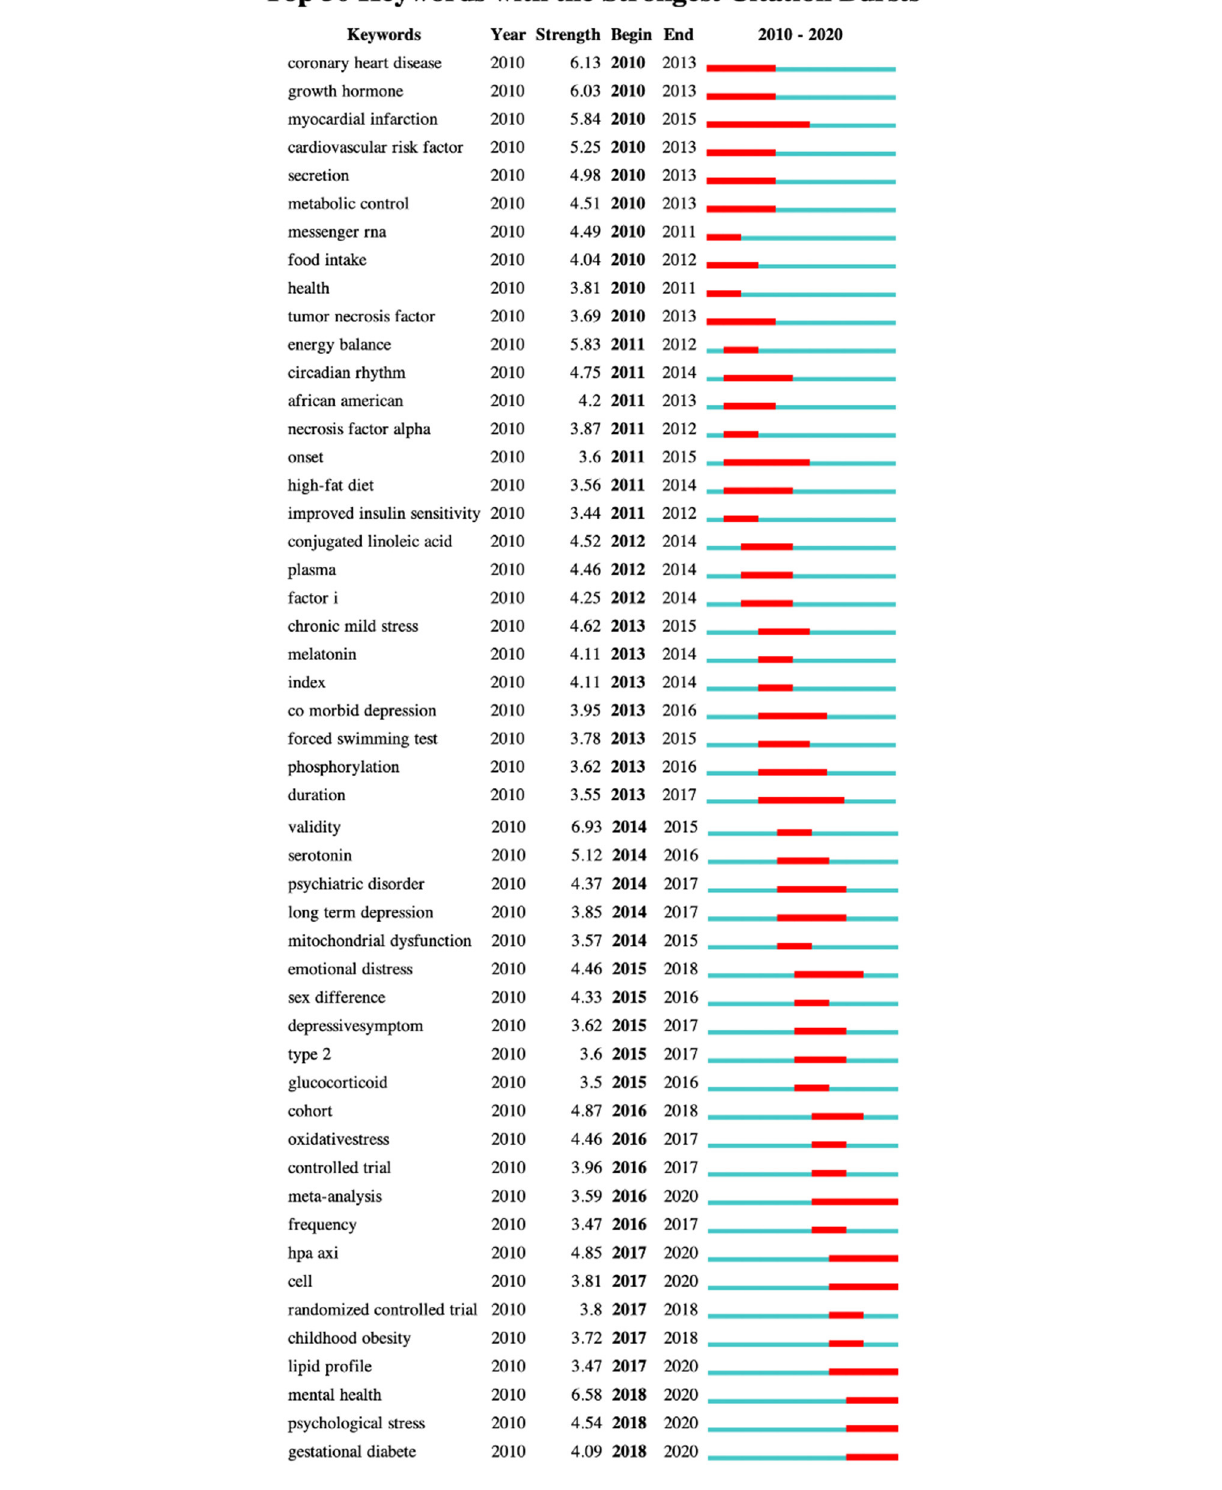
FIGURE 5 | Top 50 keywords with strongest citation